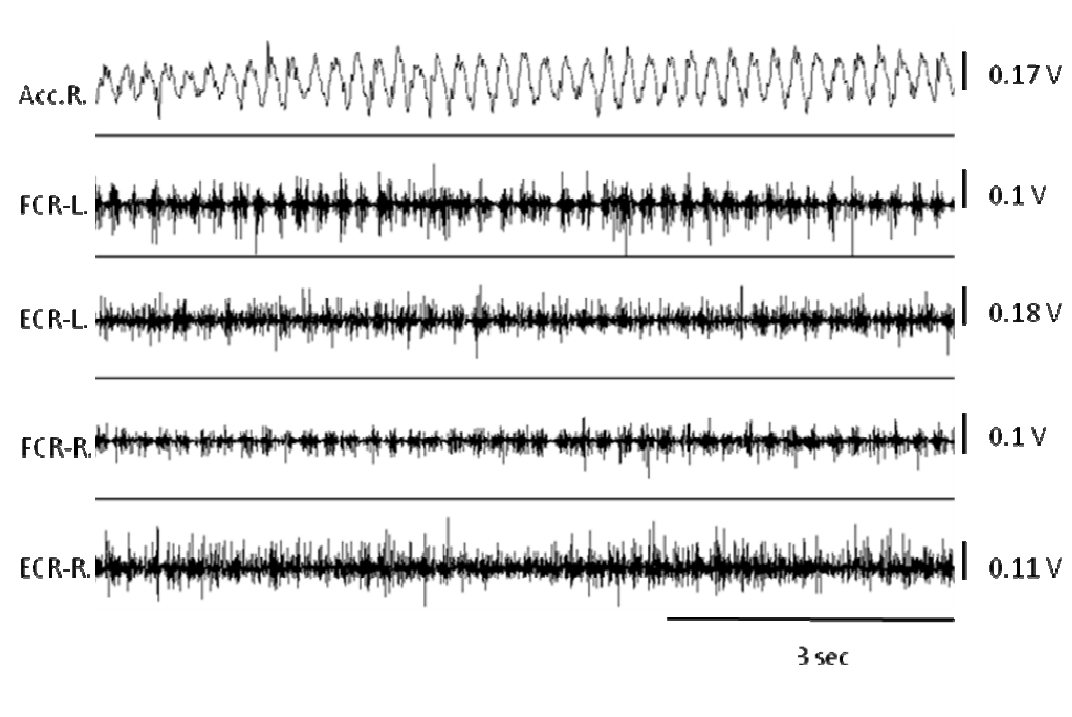
Figure 6. Example of tremor in a patient with multiple brain lesions. One single-axis accelerometer is affixed on the extremity of right index (Acc. R.) while the patient is performing the finger-to-finger test (the index fingers are maintained horizontally at a distance of about 1 cm in front of the patient). Surface EMG recordings of the flexor carpi radialis (FCR) and extensor carpi radialis (ECR) muscles are shown for both sides (L: left, R: right). Note the oscillations in the accelerometry and the regular bursts of EMG activities. Peak tremor frequency: 4.7